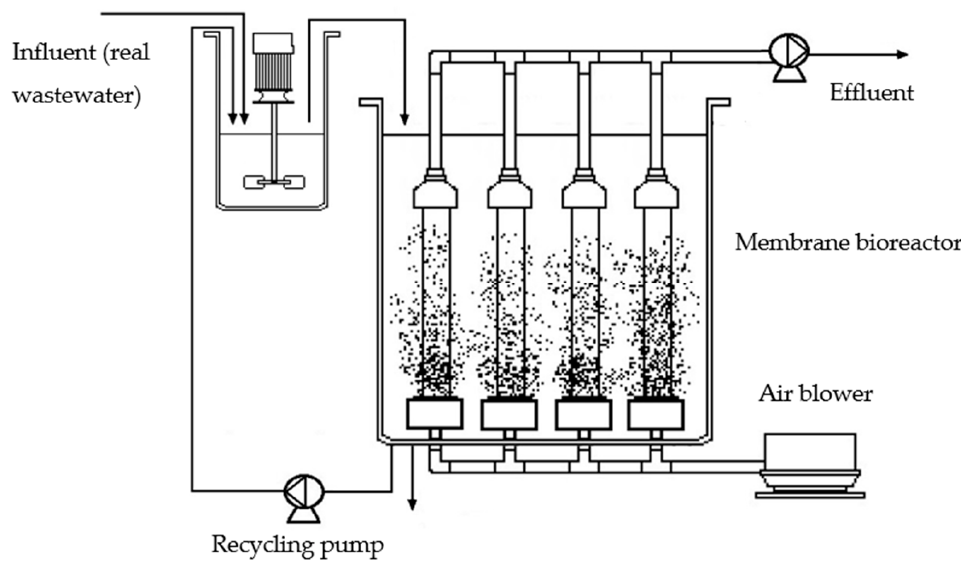
Figure 1. Schematic diagram of the pilot plant.